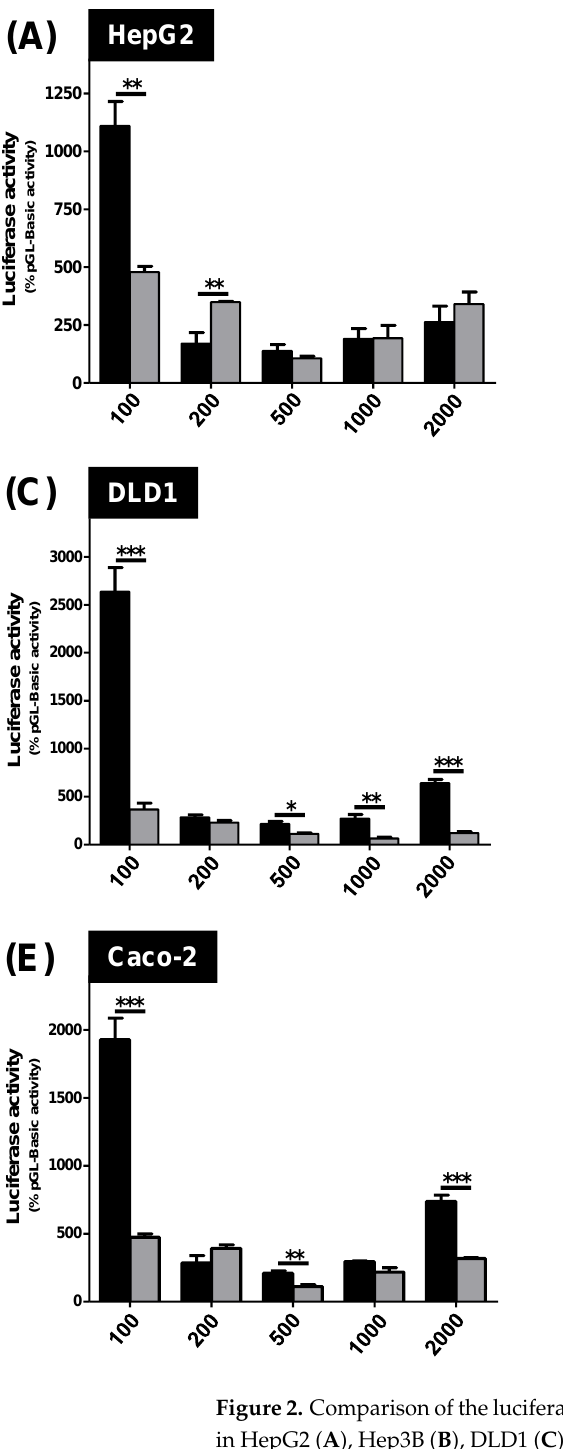
Figure 2. Comparison of the luciferase activities between Lt- and Ct-SLCO1B3 reporter gene constructs in HepG2 ( A ), Hep3B ( B ), DLD1 ( C ), T84 ( D ) and Caco-2 ( E ) cells (n = 4). In each cell line, the reporter gene constructs with the same length were compared (Ct-constructs = black bars, Lt-constructs = grey bars). The luciferase activity is shown in % of the empty pGL3-Basic activity. * p < 0.05 Ct-reporter gene construct vs. Lt-reporter gene construct; ** p < 0.01 Ct-reporter gene construct vs. Lt-reporter gene construct; *** p < 0.001 Ct-reporter gene construct vs. Lt-reporter gene construct. However, in all colorectal carcinoma cell lines (Figure 2C–E), the Ct-SLCO1B3 promoter constructs showed a significantly higher luciferase activity in most of the comparisons. In line with the qRT-PCR analysis of Ct-SLCO1B3 mRNA expression, the luciferase activity